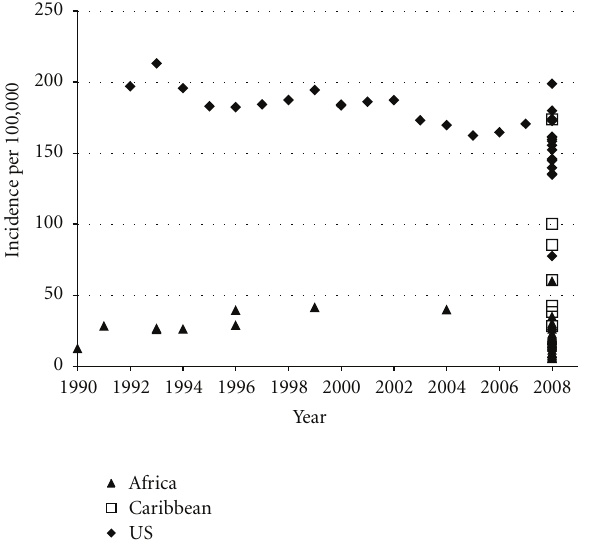
Figure 1: Estimates of CaP incidence (1990–2008) per 100,000 men of African descent, age-standardized to the 1960 world Population. Incidence rates for the USA are from SEER-13 for 1992–2008; data for 2008 include one estimate from each of the SEER-17 registries, except two registries with < 16 cases. Incidence rates for all Caribbean countries are from 2008 GLOBOCAN data. Incidence rates for African countries are from specific population-based cancer registries for 1990–2004 and from 2008 GLOBOCAN data. Rates can be found in Supplementary Table 1. Incidence rates are age-standardized to the 1960 world